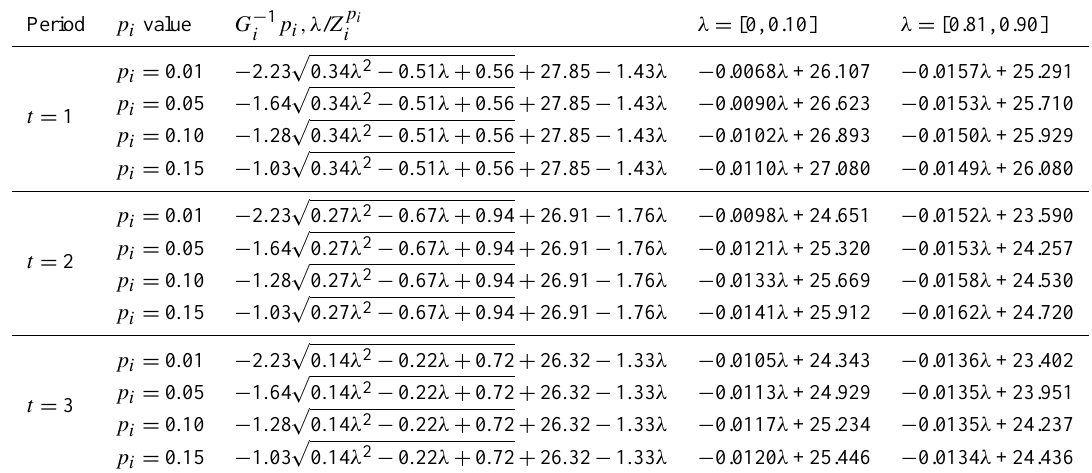
Table 3. Linearization results of surface water availability.